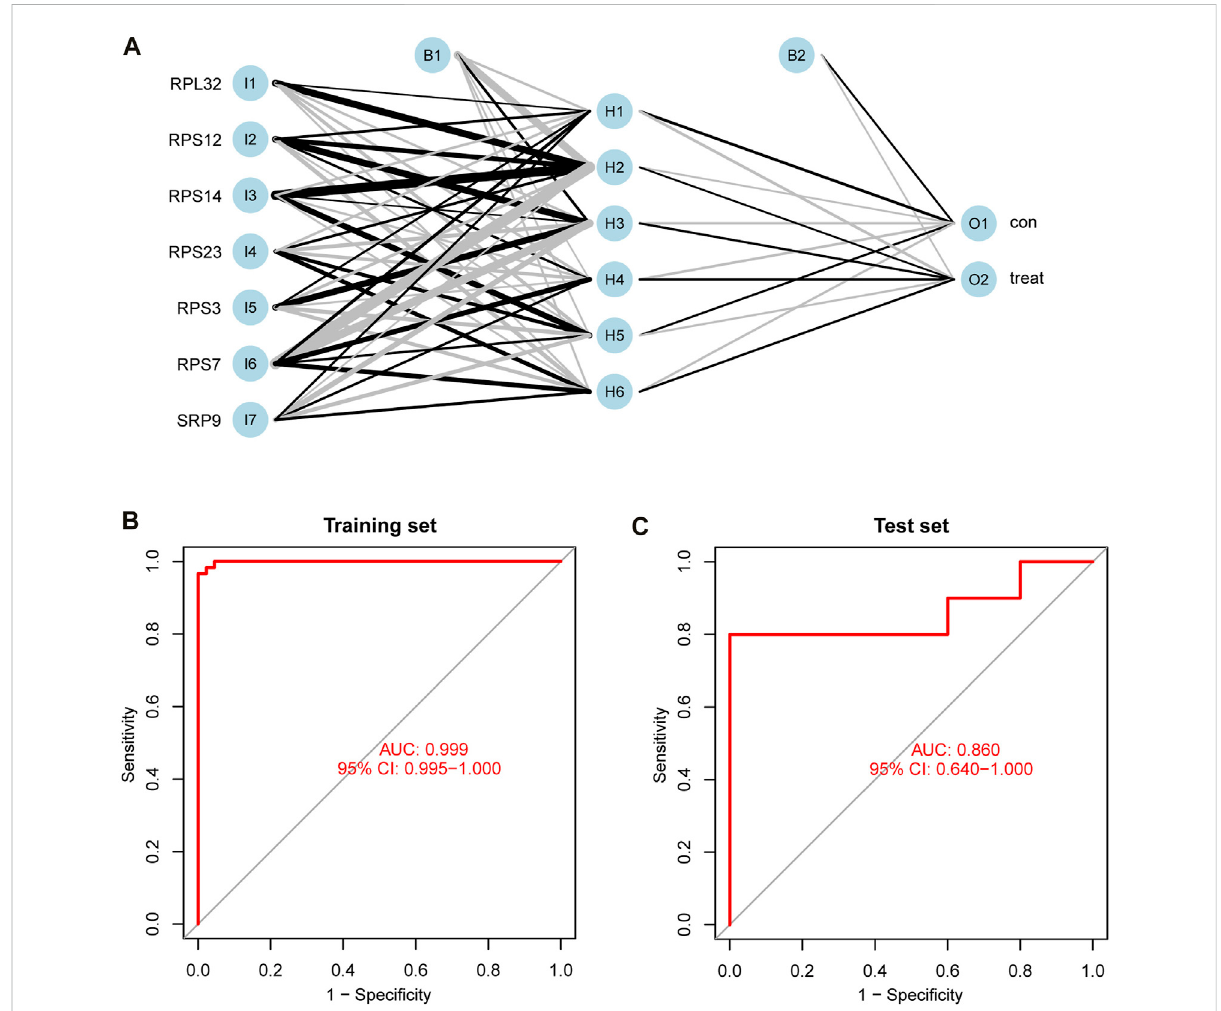
FIGURE 10 Construction and validation of ANN. (A) The process ofconstructing ANN. (B) ROC curve of ANN inthe training set with an AUC value of 0.999. (C) ROC curve of ANN in the test set with an AUC value of 0.860. 95% CI: 95% con fi dence